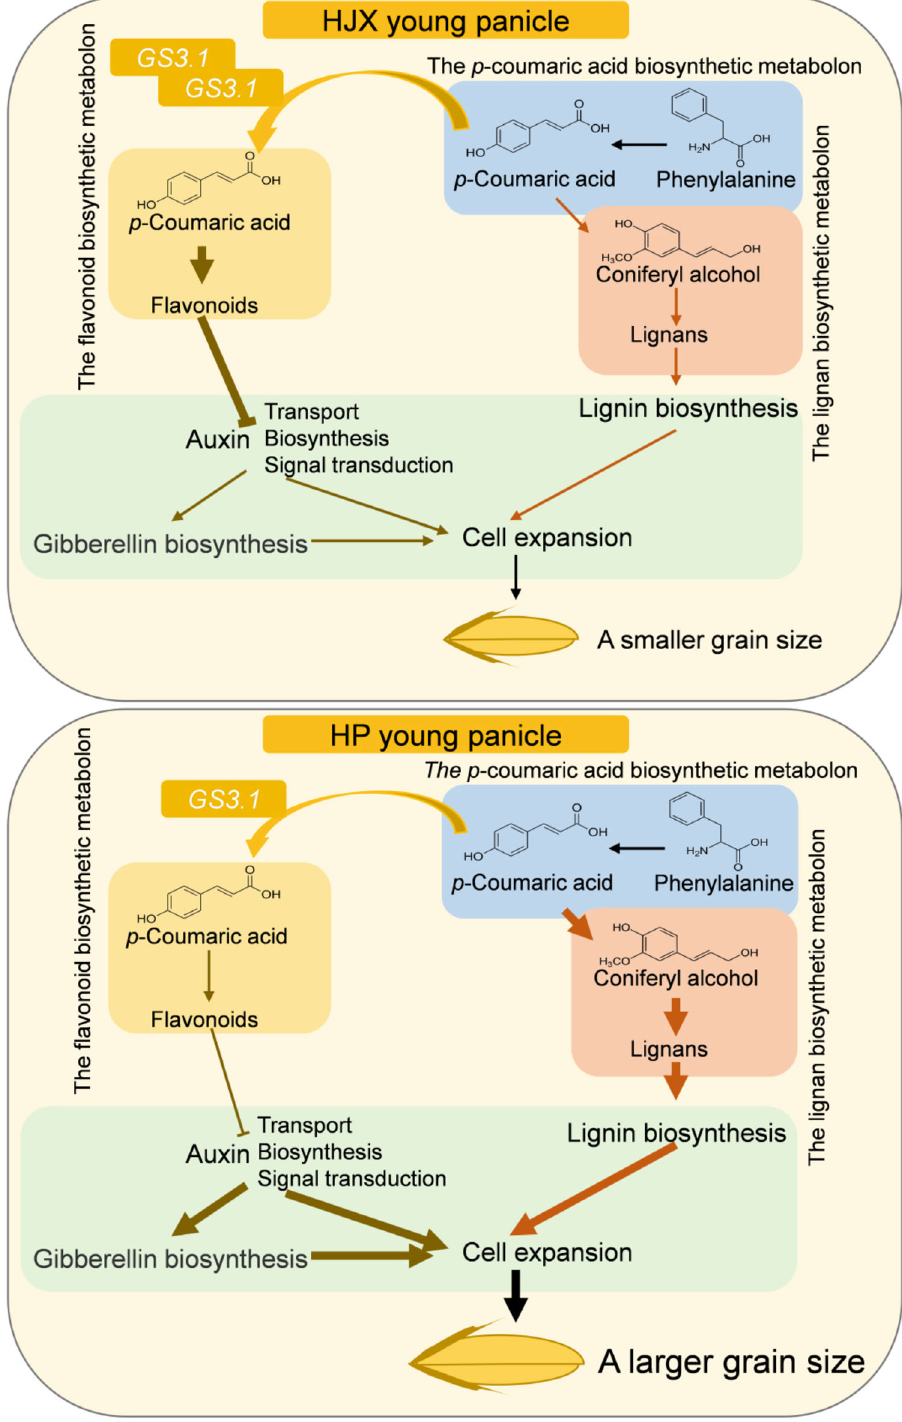
Fig. 6 Conceptual model of the role of GS3.1 in the regulation of grain size in rice. In HP young panicles, a lower GS3.1 expression level leads to reduced GS3.1 protein. As a result, less p -coumaric acid is transported to the fl avonoid biosynthetic metabolon, which reduces fl avonoid biosynthesis and instead increases p -coumaric acid availability for lignan biosynthesis. The decreased fl avonoid content weakens the suppression of the auxin transport, biosynthesis and signal transduction, which in combination with subsequent activation of the gibberellin signaling and the increased lignin content results in a larger grain size in